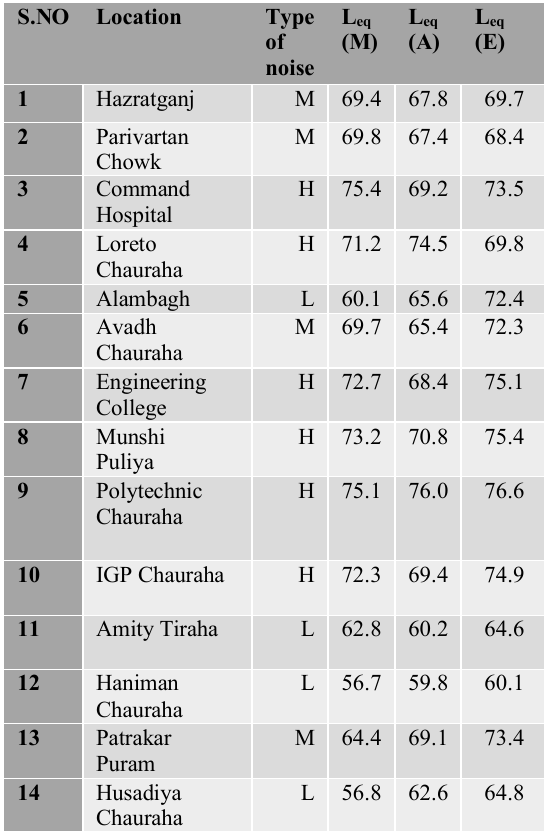
Table 3. The Leq values at a different location and the different slot has been shown. Nomenclature H, M, L are high, medium, low-level noise, and here M, A, E stands for the morning, afternoon, and